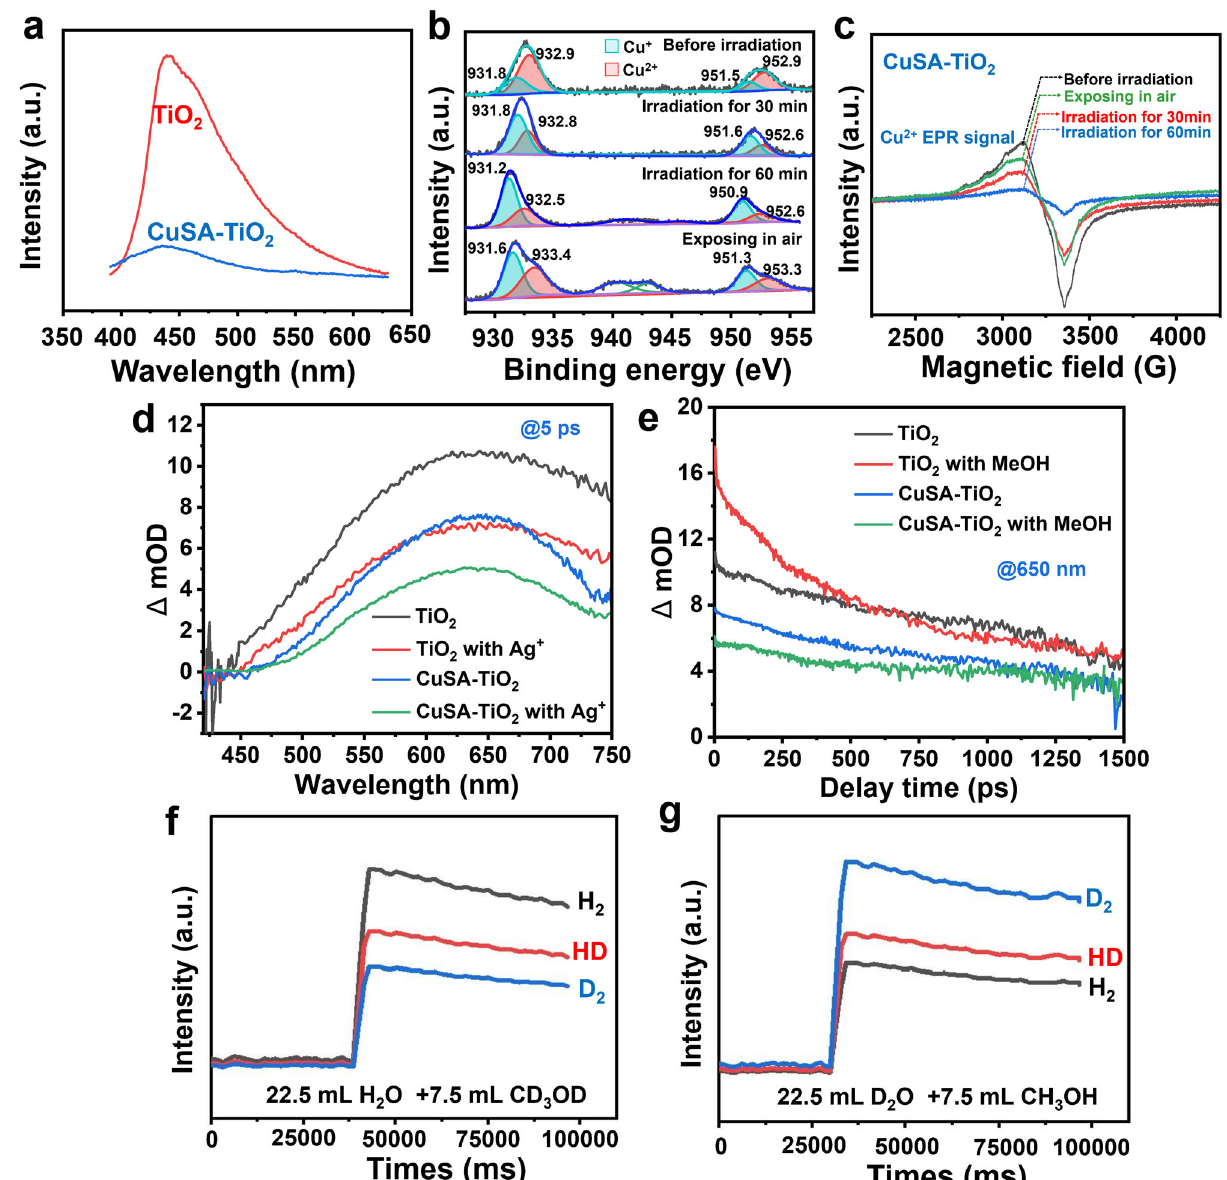
Fig. 3 Carrier transfer mode and carrier dynamics of CuSA-TiO 2 . a Photoluminescence spectra of TiO 2 and CuSA-TiO 2 under an excitation wavelength of 375 nm. b In-situ Cu 2 p XPS of CuSA-TiO 2 . c In-situ electron paramagnetic resonance spectra of CuSA-TiO 2 with various states. d Transient